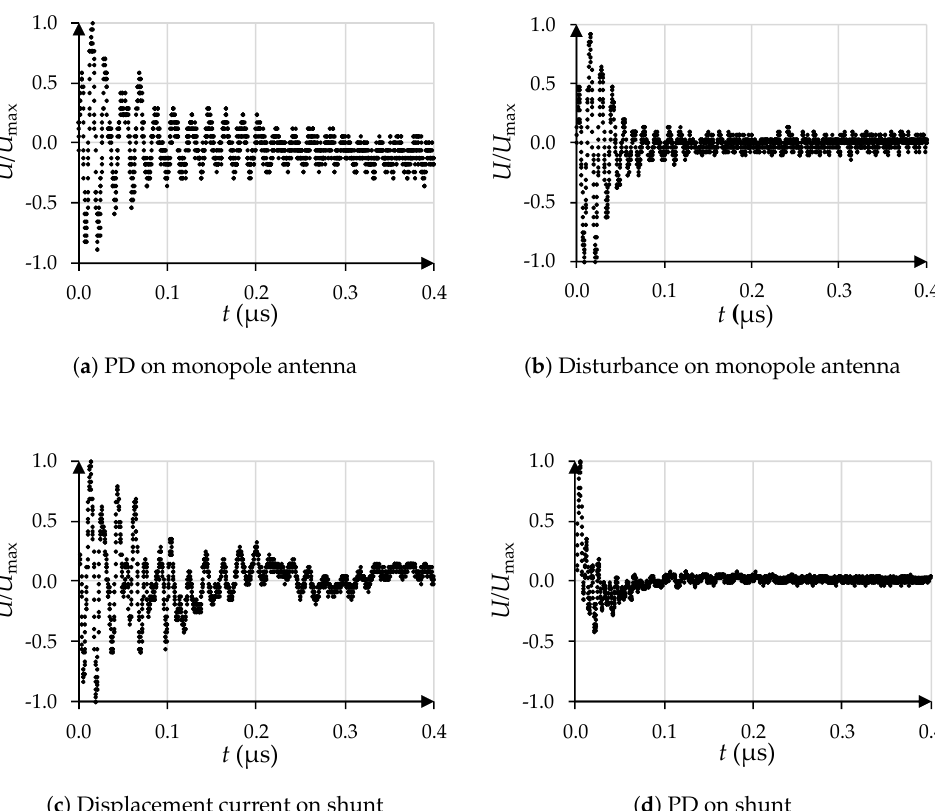
Figure 7. Detail of the normalized signal components detected by the monopole antenna and the